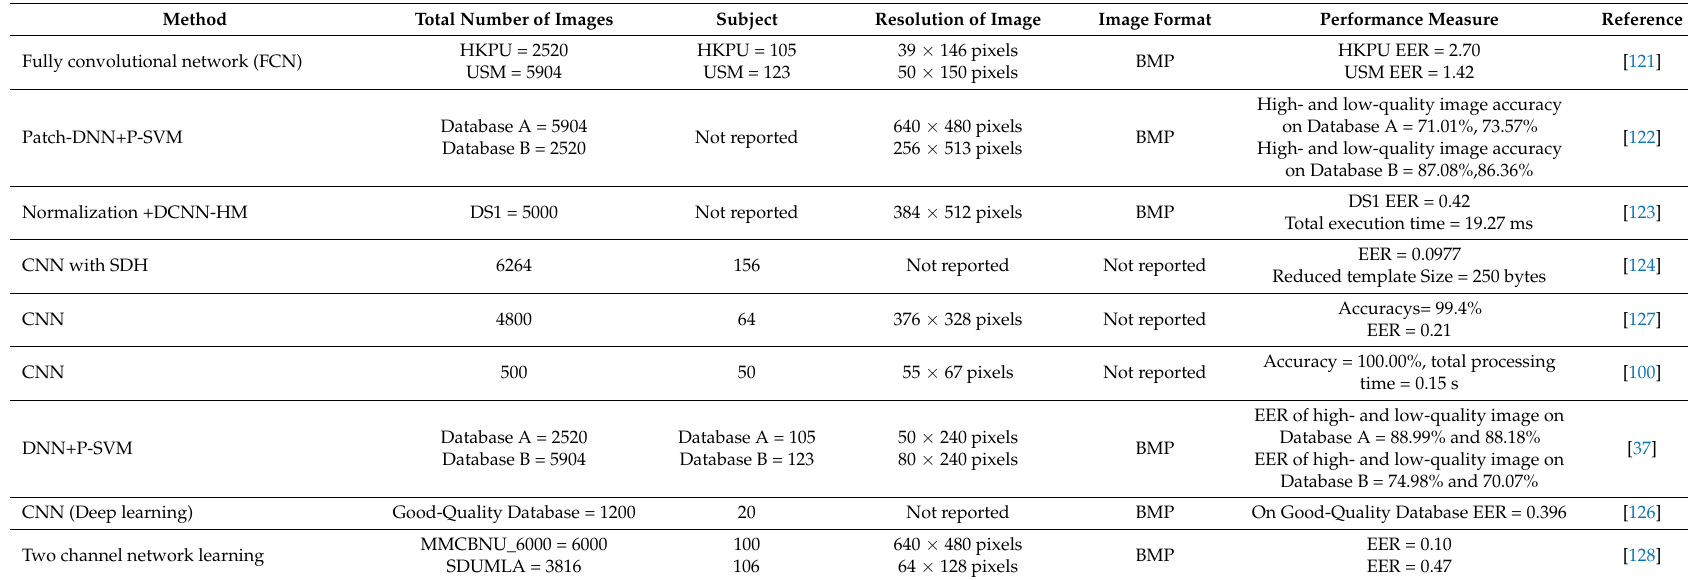
Table 7. Finger vein recognition performance using deep learning